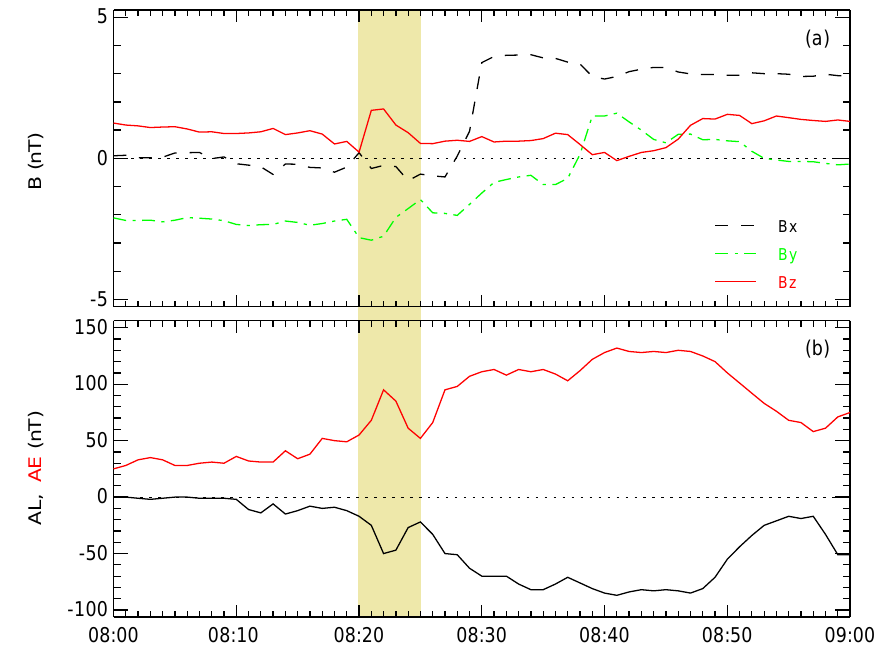
Fig. 1. (a) The IMF components seen by Wind propagated to 1AU (Details of the applied time shift can be found on the CDA website for the OMNI data source. The averaged time shift for this interval is ∼ 50min), with the interest interval; (b) AL and AE indices.